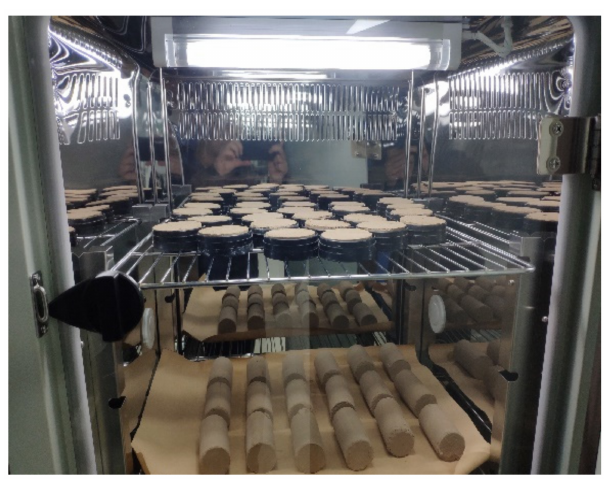
Figure 4. Sample production flow chart.